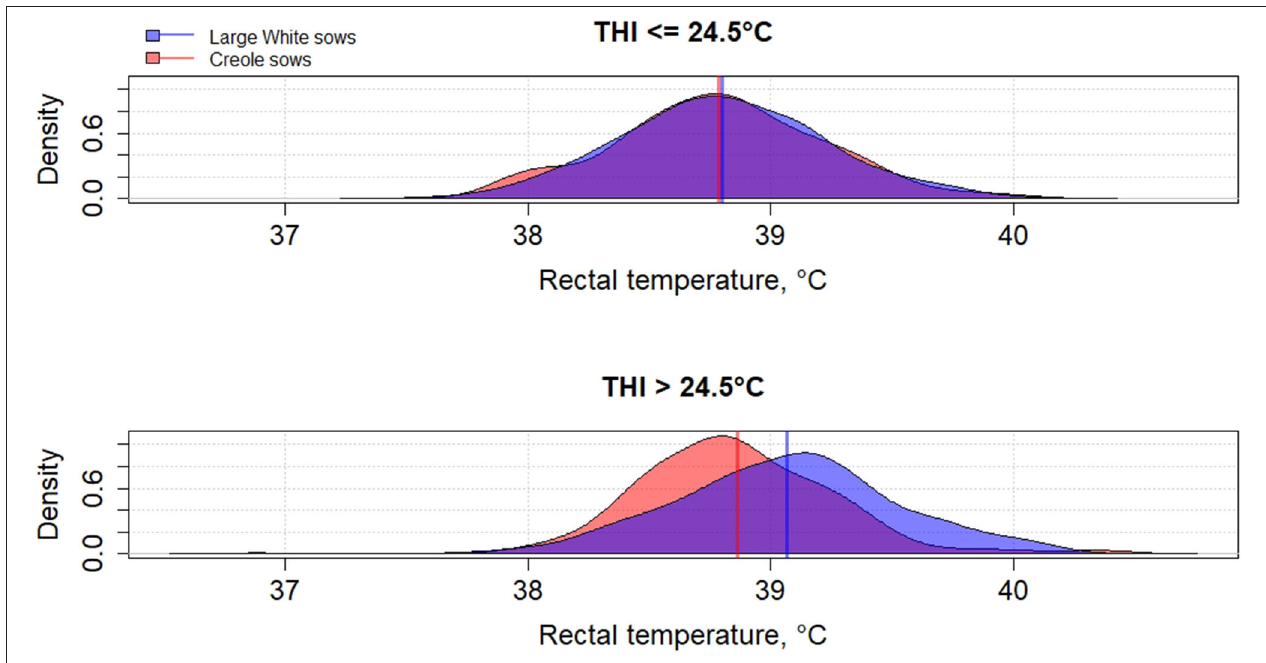
FIGURE 2 | Density distribution of average rectal temperature of Creole and Large White lactating sows according to the average thermal-humidity index (THI) during lactation [adapted from Gourdine et al. (